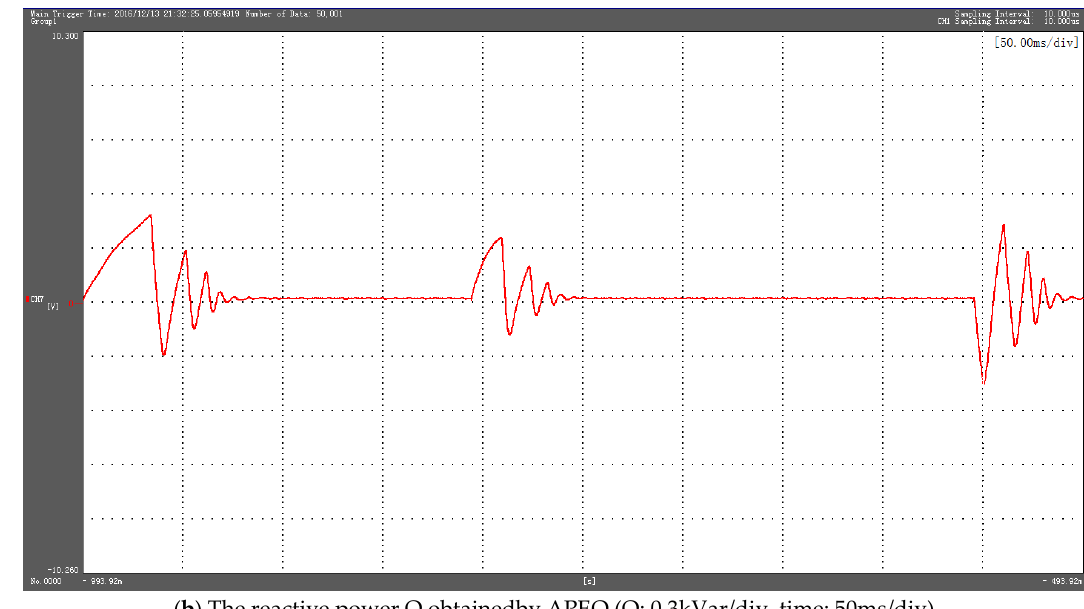
Figure 12. The experimental dynamic response of the active and reactive powers obtained by APEO when the reference value of the active power P ref increases suddenly from 0.5 kW to 2.5 kW and decreases suddenly from 2.5kW to 0.5kW.